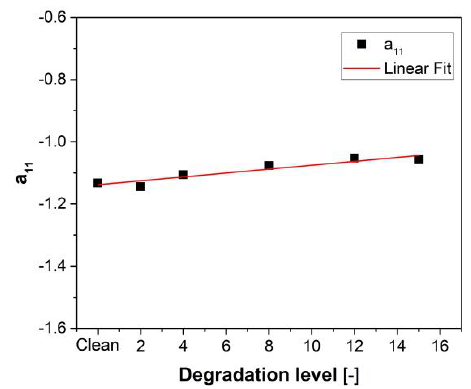
Figure 5. Coefficient a 11 computed from linearization for different levels of compressor degradation (dots) and the linear fit curve.